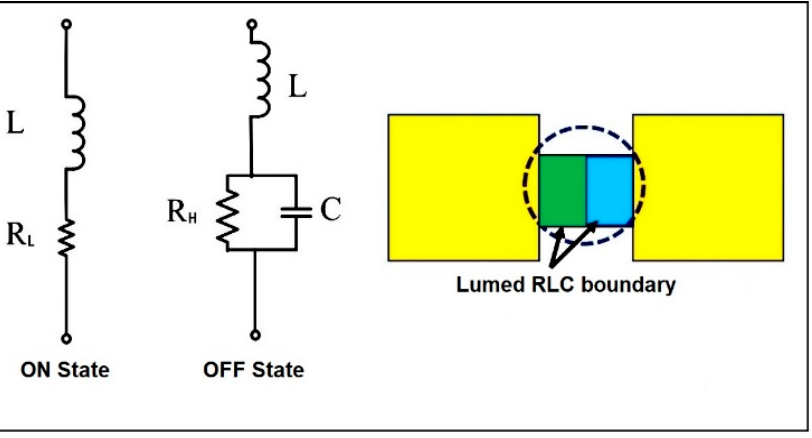
Figure 2. The equivalent circuits of pin diode and its CST model.